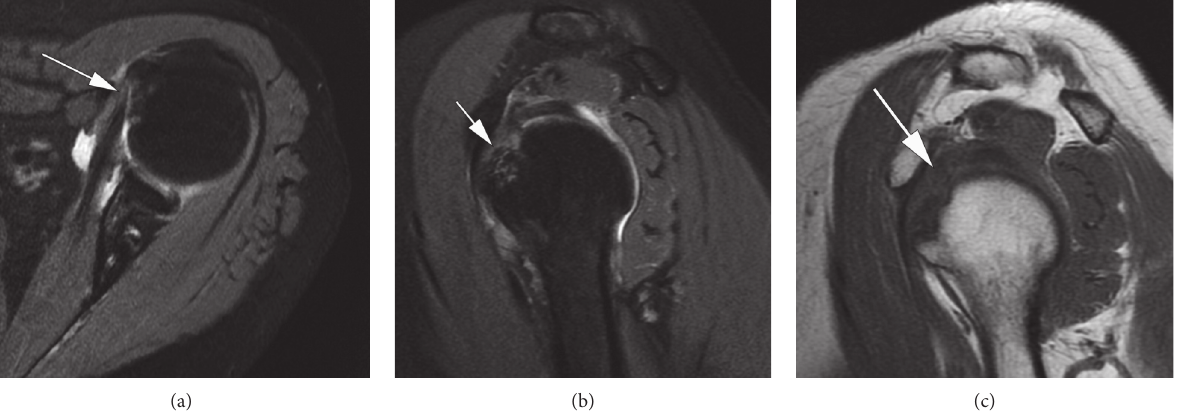
Figure 7: A 64-year-old woman with left shoulder pain after a fall. Axial (a) and sagittal oblique (b) T2-weighted FS MRI demonstrates a partial insertional tear of the subscapularis tendon (arrow). Sagittal oblique T1-weighted MRI (c) demonstrates loss of fat within the rotator interval (arrow).